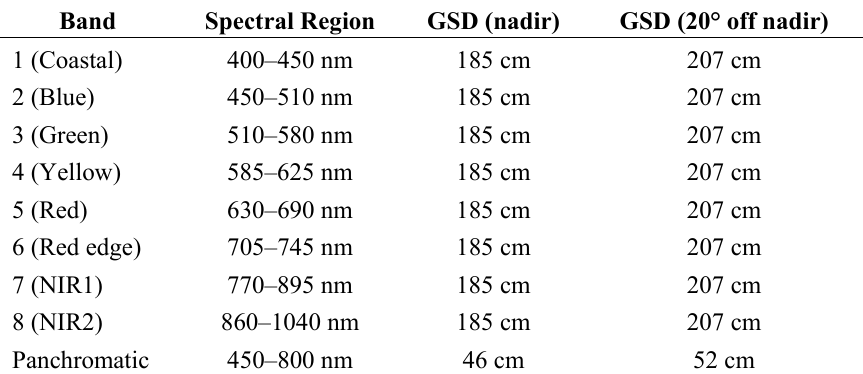
Table 1. WorldView-2 specifications of the spectral